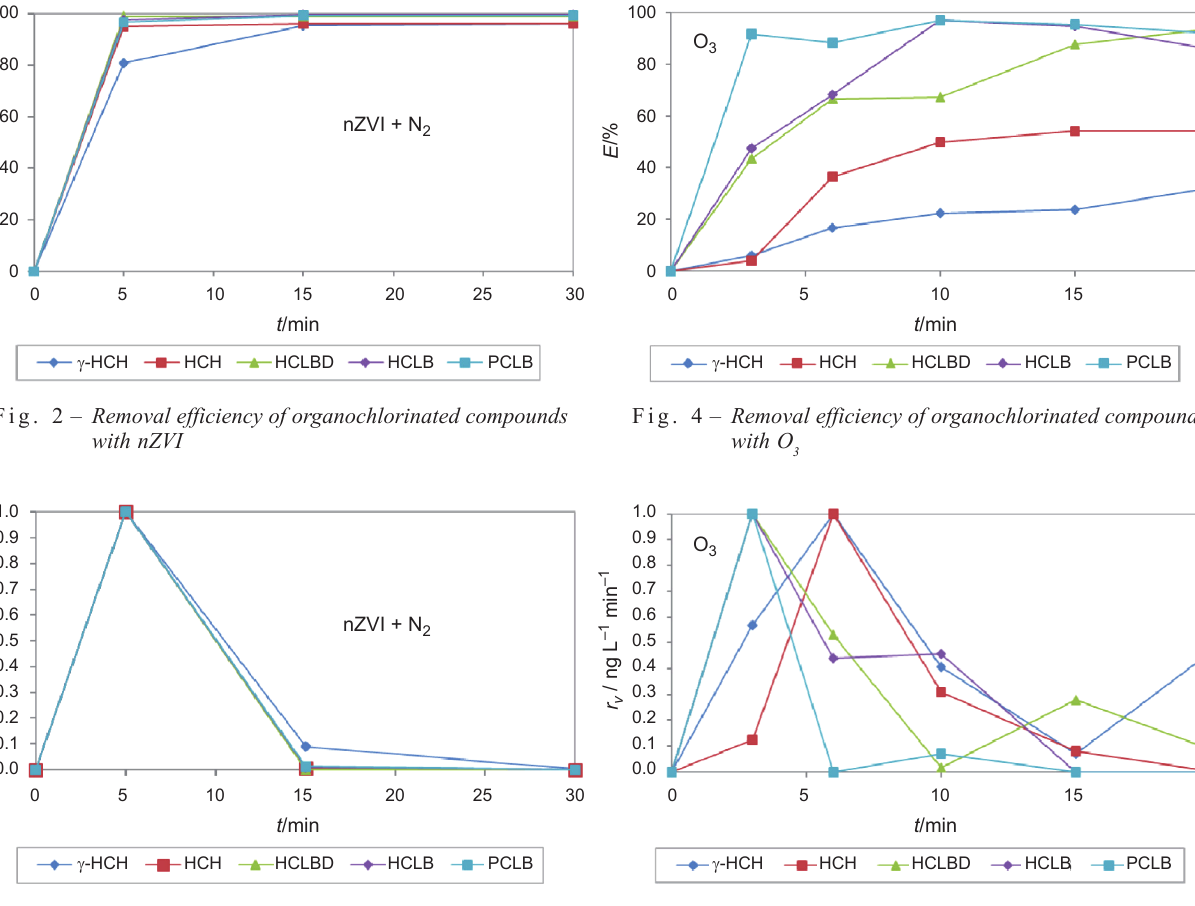
Fig. 5 – Removal rates of organochlorinated compounds with